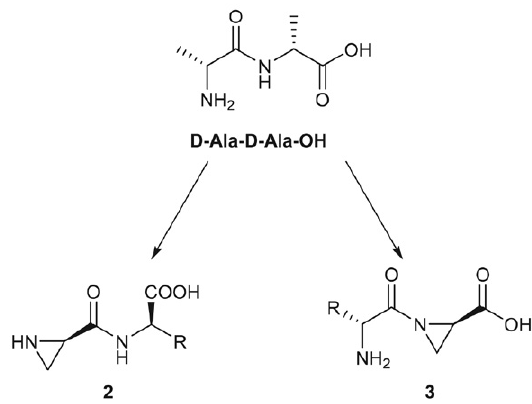
Figure 2 . N- and C-terminal aziridine containing